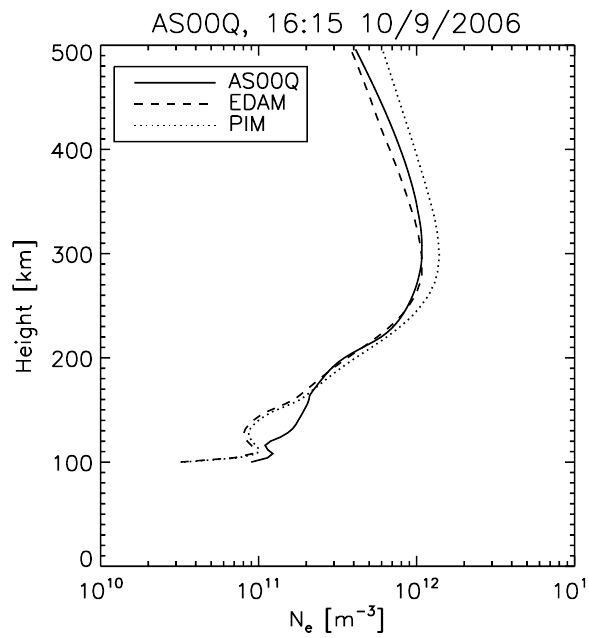
Fig. 3. Example comparison between PIM, EDAM and a ver- tical electron density profile measured by the Ascension Island